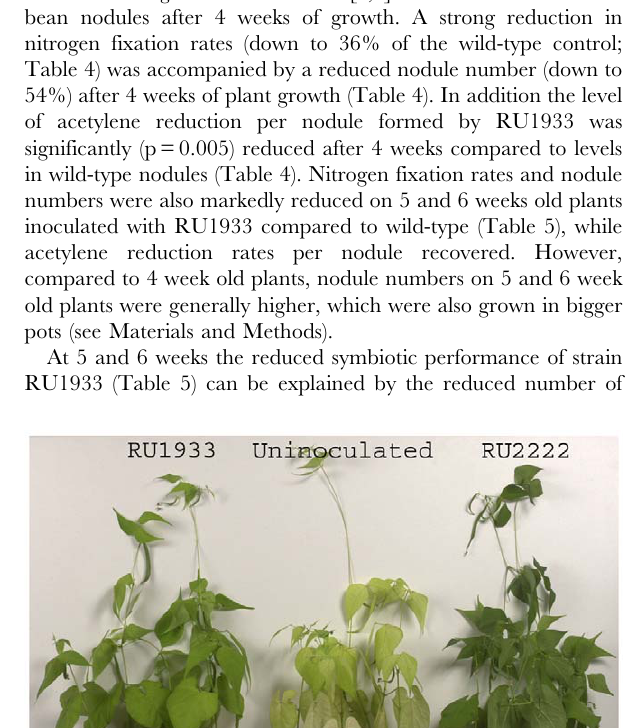
Table 3. Transport of amino acids and plant dry weights by strains of R. leguminosarum bv phaseoli.